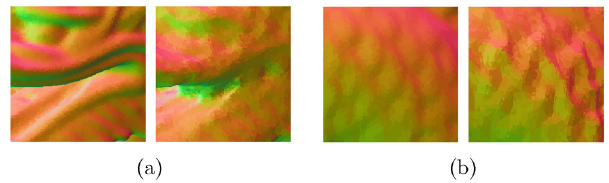
Fig. 5 Ground truth (left) and reconstructed (right) surface normal. (a) Blurry example. (b) Bumpy example.